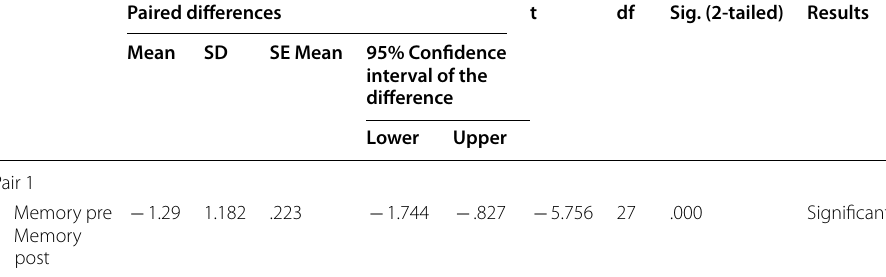
Table 2 Paired samples test: memory. Source: SPSS 23.0 output